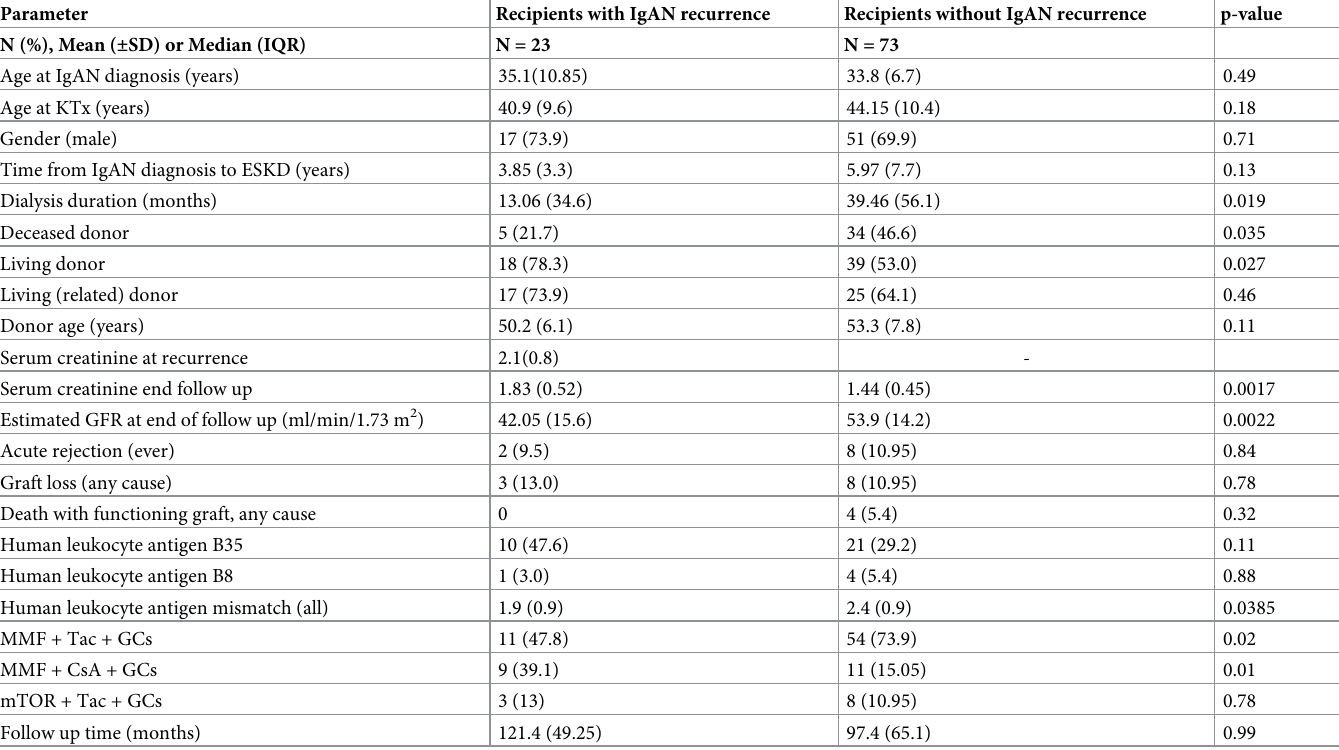
Table 4. Comparison of baseline characteristics and outcomes of KTx recipients with IgAN recurrence in the graft versus recipients without IgAN